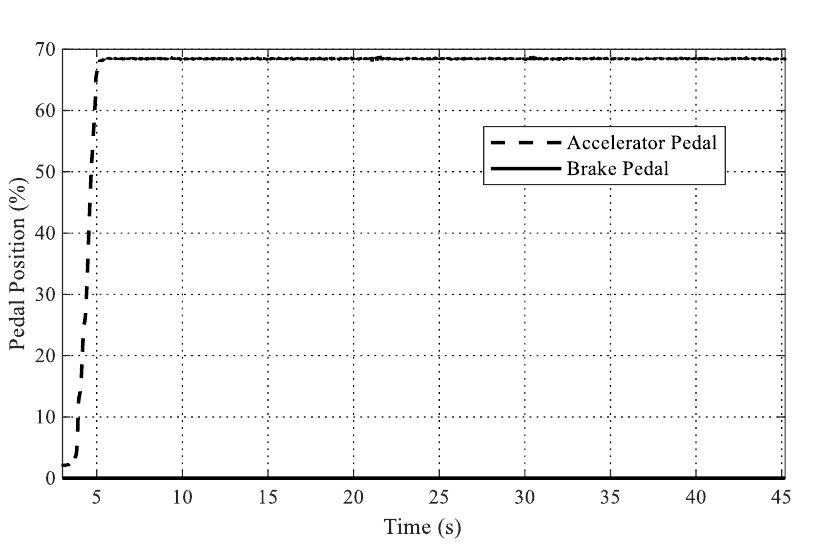
Figure 16. Accelerator and Brake Pedal Position for Scenario 2 and 3.